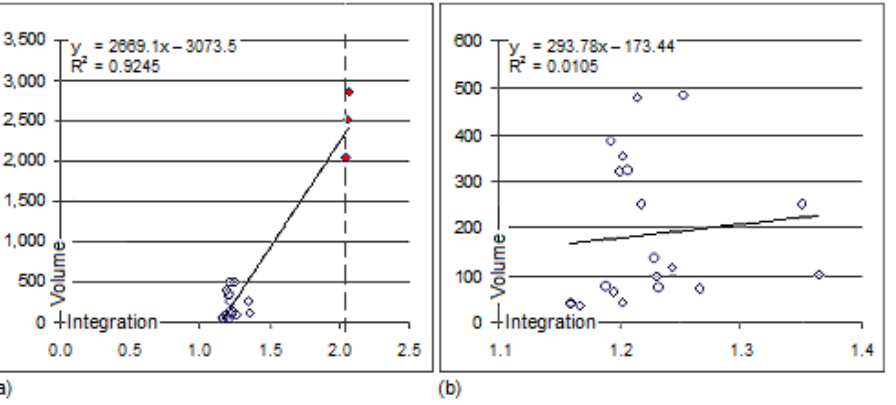
Figure 7. Scatterplots: type 1 unit-segment analysis. (a) All-roads. (b) Residential-streets. The scatter of Figure 7(a) shows a significantly strong post-diction accounting for the majority of the variance (r 2 ~ 0.9) in flows of the arteries and the residential streets. The scatter again develops two outliers separating the arteries from the residential streets. The imaginary line here